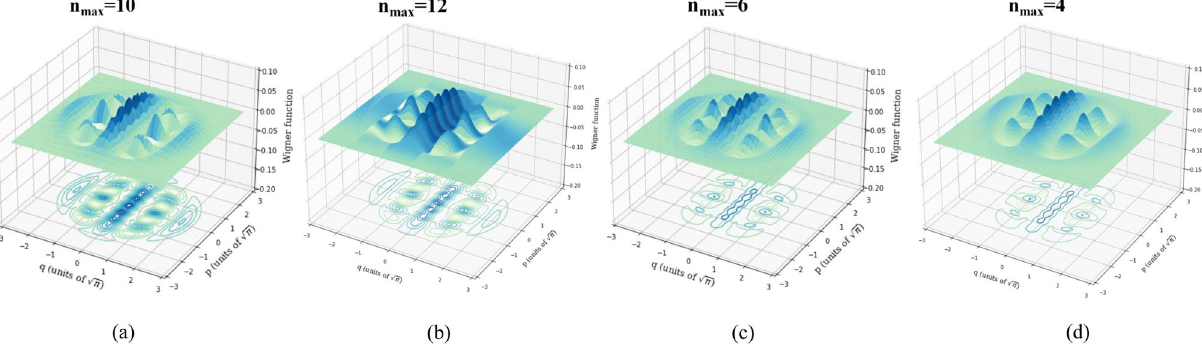
Fig. 5 Wigner function at different photon numbers. a The fi gure shows a standard diagram of the Wigner function for 0 Δ j i at n max ¼ 10 with compression noise below 10 dB. From b to d , it can be seen that as n max decreases, the number of peaks becomes less and less (the darker color indicates that the number of peaks here is more, and the noise reduction effect is better). In addition, from left to right, it can be seen that the phase space state after projection (bottom illustration, the darker the color is closer to the origin, the closer to the 0 Δ j i state) becomes more and more dispersed, and the difference is getting bigger and bigger. It follows that the number and sharpness of peaks are closer to 0 Δ j i at n max ¼ 10